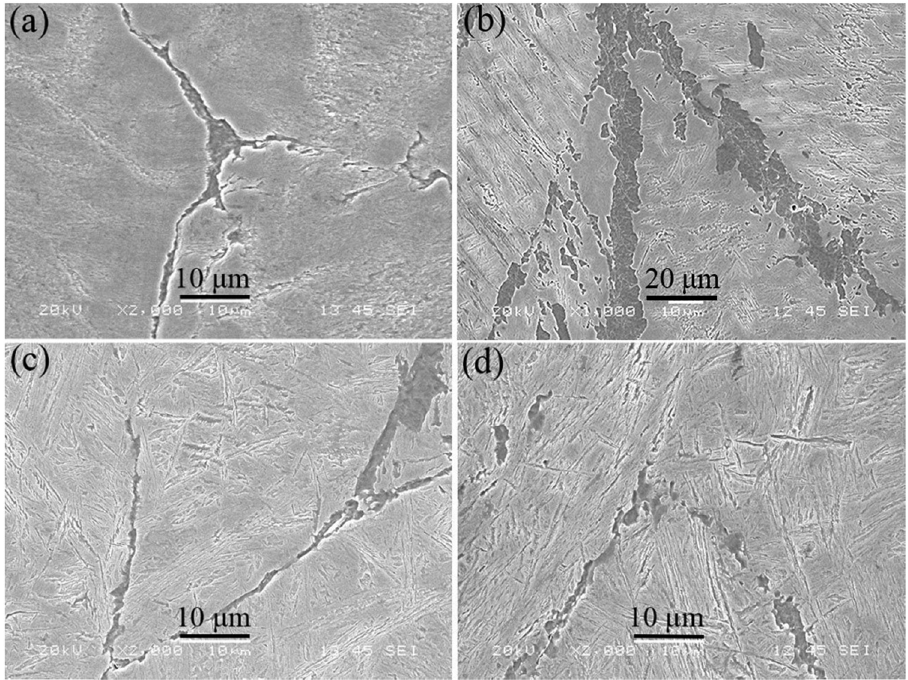
Figure 6: Microstructures near fracture surface at 700°C with a strain rate of 0.005 s − 1 observed by SEM: ( a ) steel 1#; ( b ) steel 2#; ( c ) steel 3#; ( d ) steel 4#.